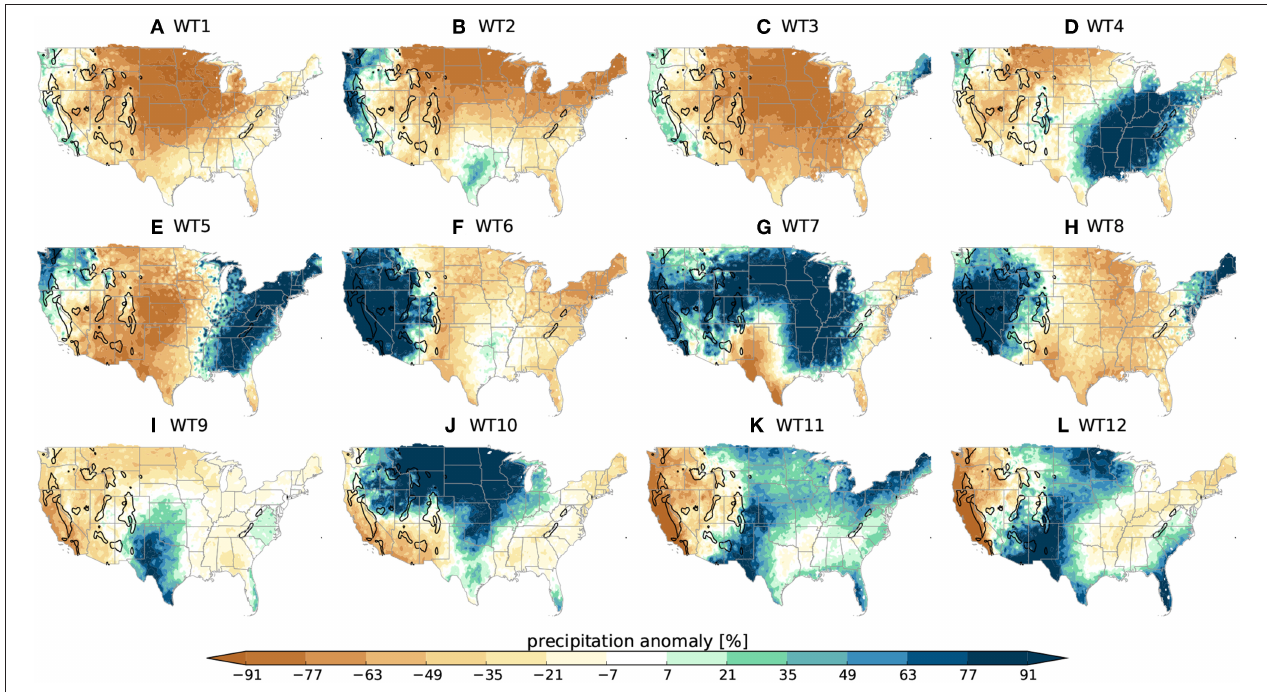
FIGURE 4 | Precipitation anomalies for each WT (A–L) based on the PRISM daily gridded observational data between 1981 and 2014 (Daly et al., 1994).